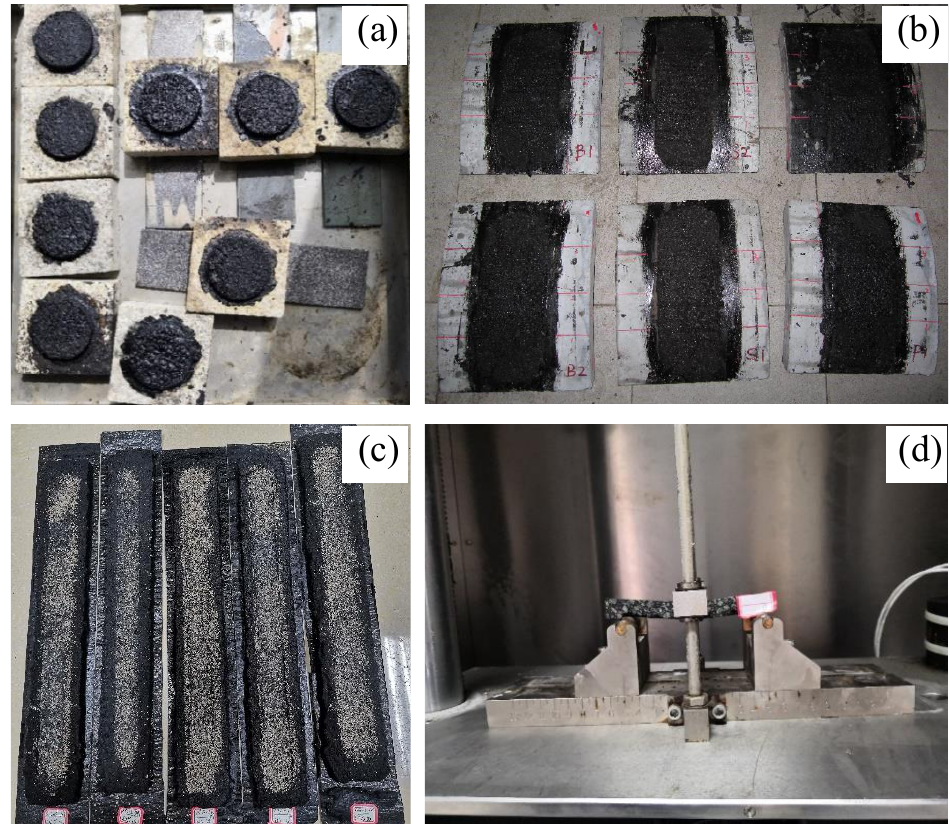
Figure 2. Conducted tests: ( a ) MBS, ( b ) DWPA, ( c ) LWT, and ( d )